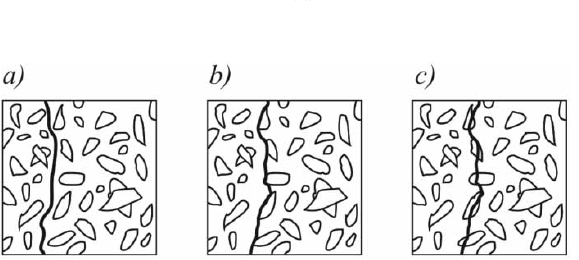
Fig. 4. Types of destruction of specimens made of sulphur and plant origin inserts: (a) typical of boon and sawdust inserts, (b) straw, (c) sawdust